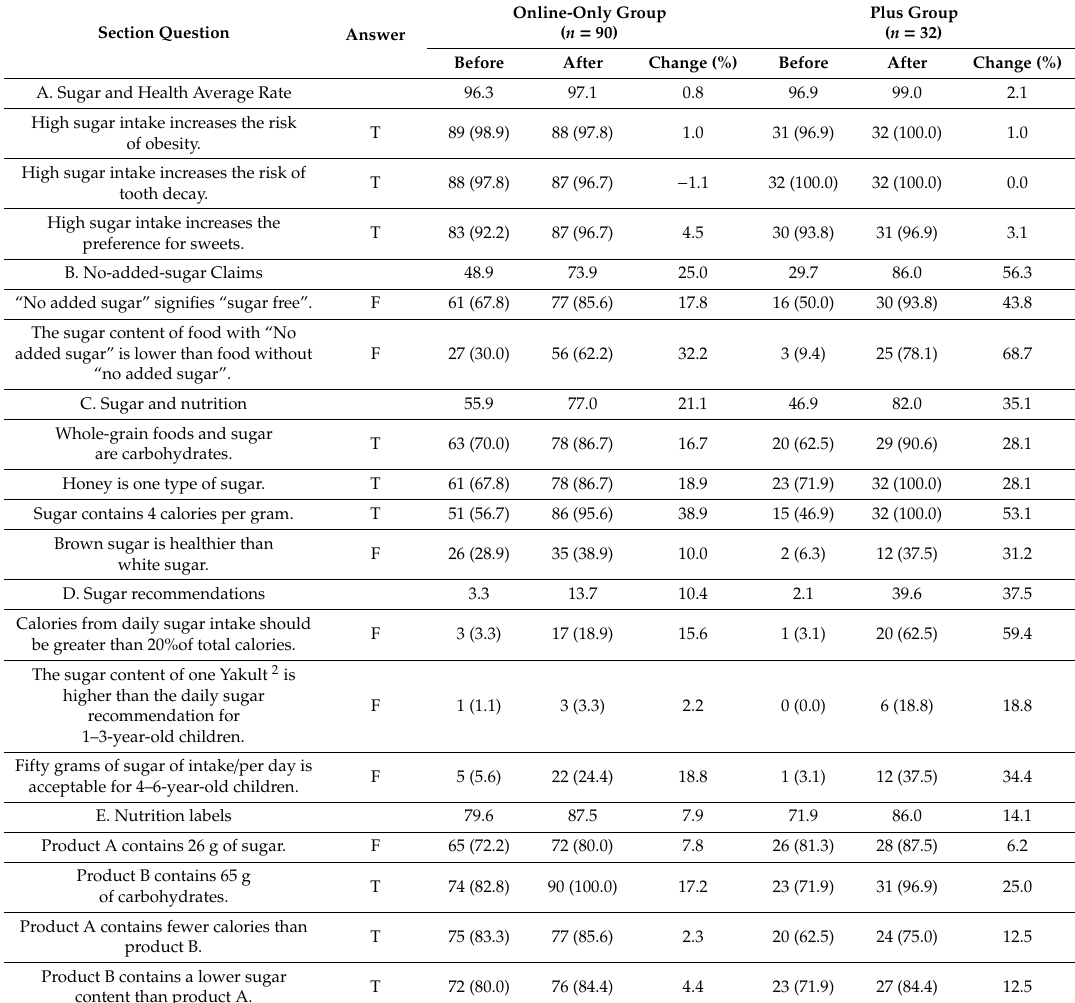
Figure 3. Constructs of the theory of planned behavior in this study ( n = 122). Table 3. Correct knowledge rates about sugar and nutrition labels in both groups 1